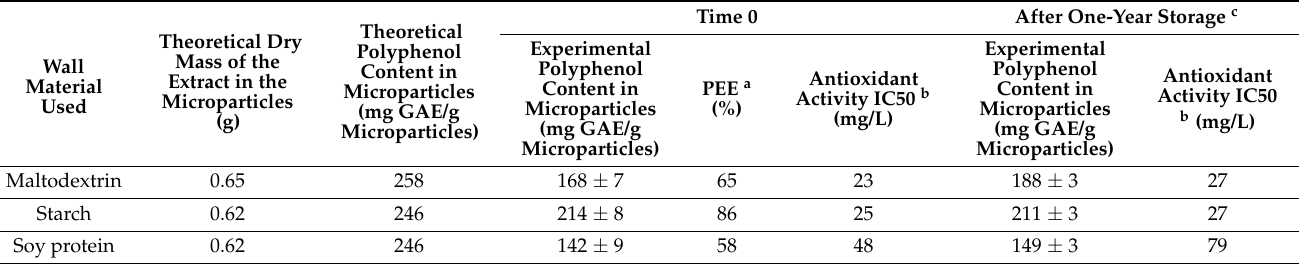
Table 4. Polyphenol content and antioxidant activity of the microparticles with MAE and evolution after one-year storage at room